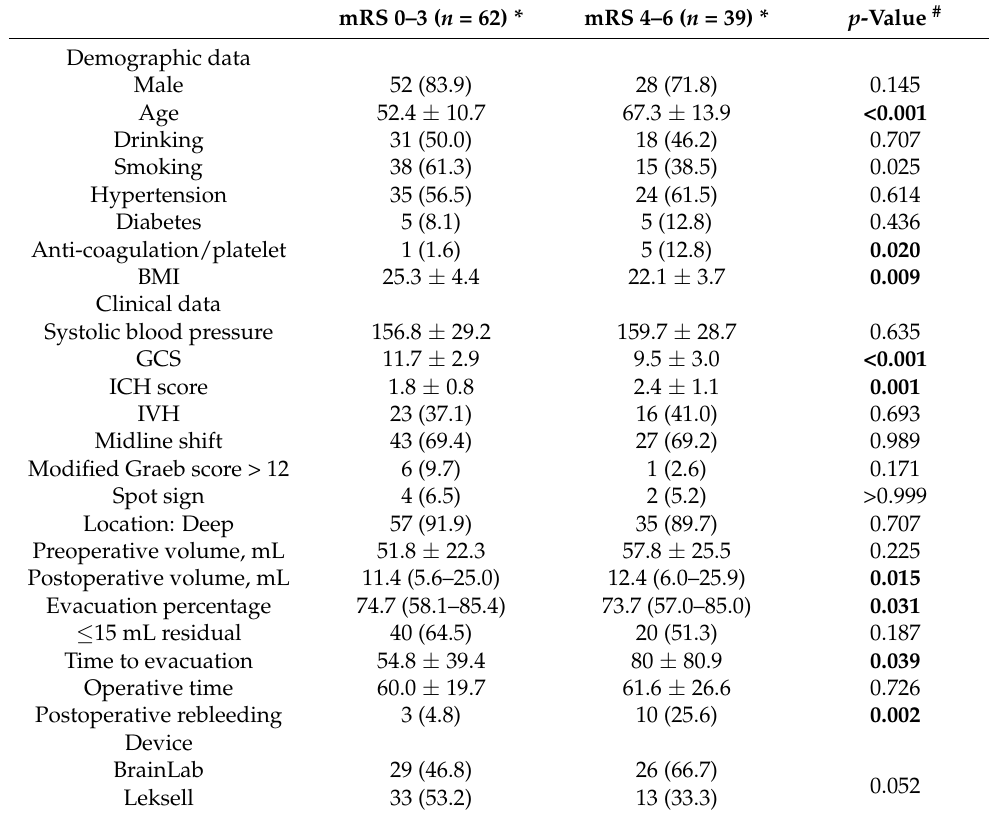
Table 4. Univariate analysis of poor outcome 1 year after discharge.